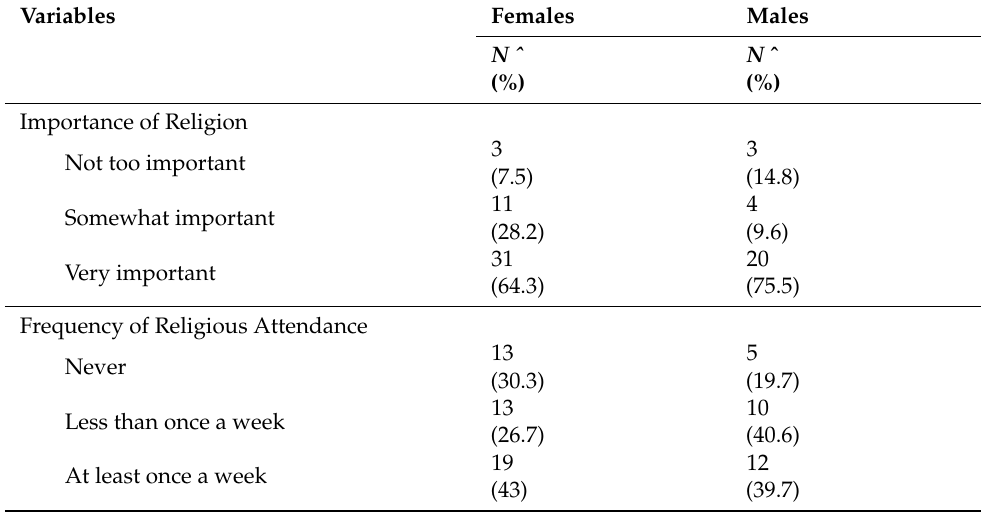
Table 3. Religious Frequencies of Females and Males.